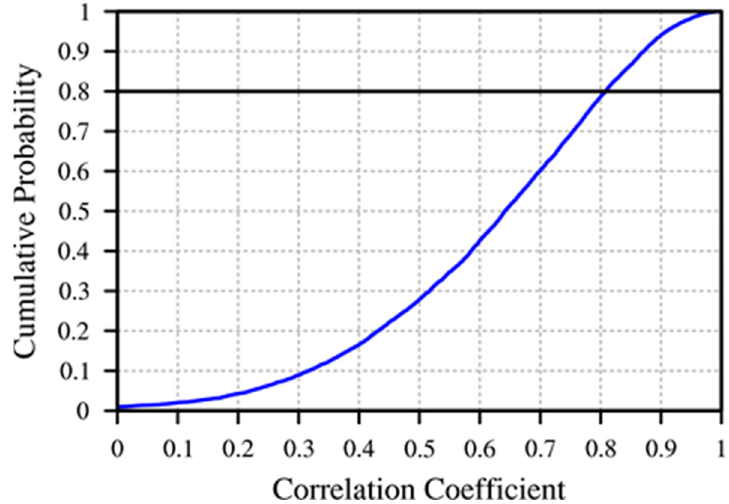
Figure 4. The cumulative probability of distribution of grid-point correlation coefficients shown in Figure 3 from 17 August 2016 to 6 September 2016.